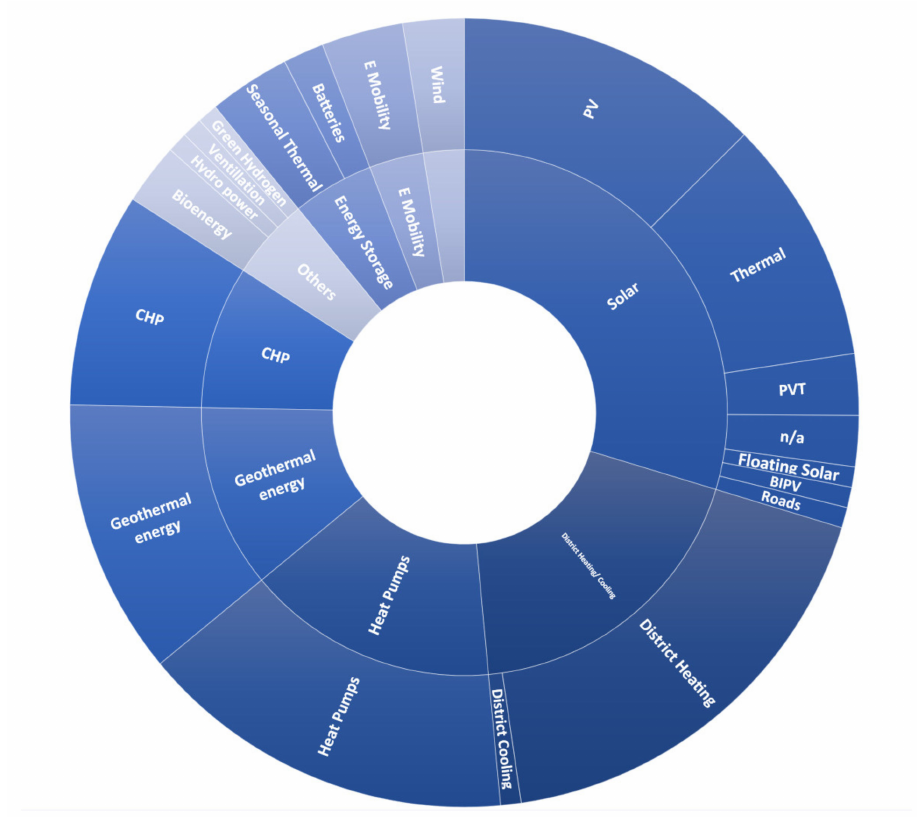
Figure 7. Commonly used energy technologies. Figure 8 represent the diversity of energy technologies in each country. Solar energy, district heating/cooling and heat pumps technologies are commonly considered in almost of the countries, geothermal energy and CHP plant are being used in nearly half of the countries as represented in Figure 8. Wind energy is integrated in a smaller number of countries such as Denmark, Finland, Germany, The Netherlands and Turkey, and energy storage is only seen in few countries such as Austria, Finland, Germany, Italy, Norway and Turkey.